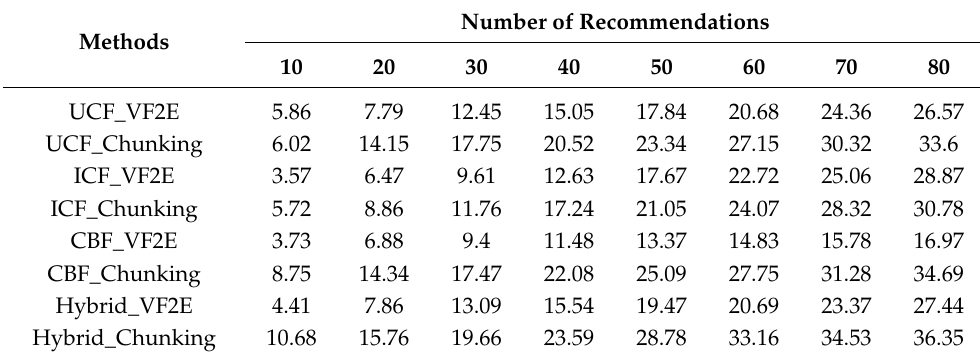
Table 1. Performance comparison of baseline methods and proposed method.